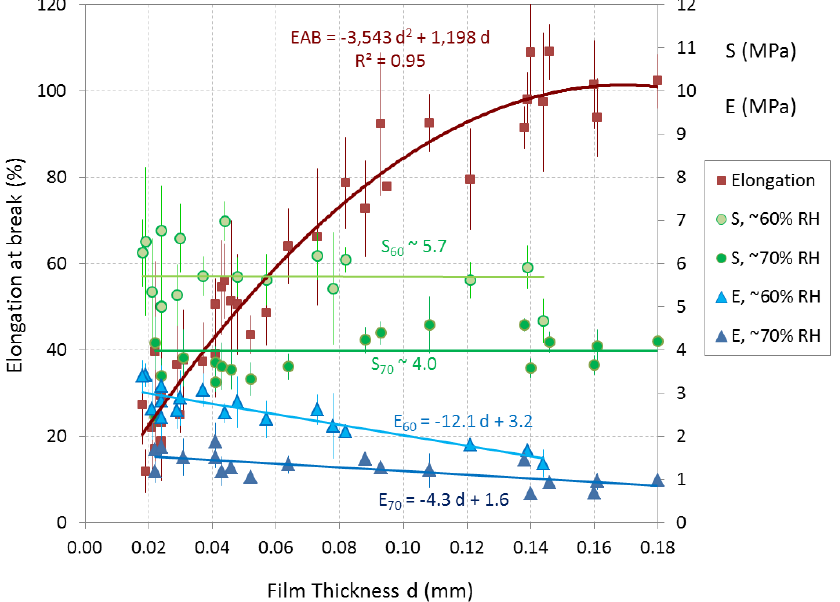
Figure 1. Control A films: tensile modulus (E), tensile strength (S) and elongation at break (“elongation”, EAB) from 58% to 70% room humidity (RH), as a function of film